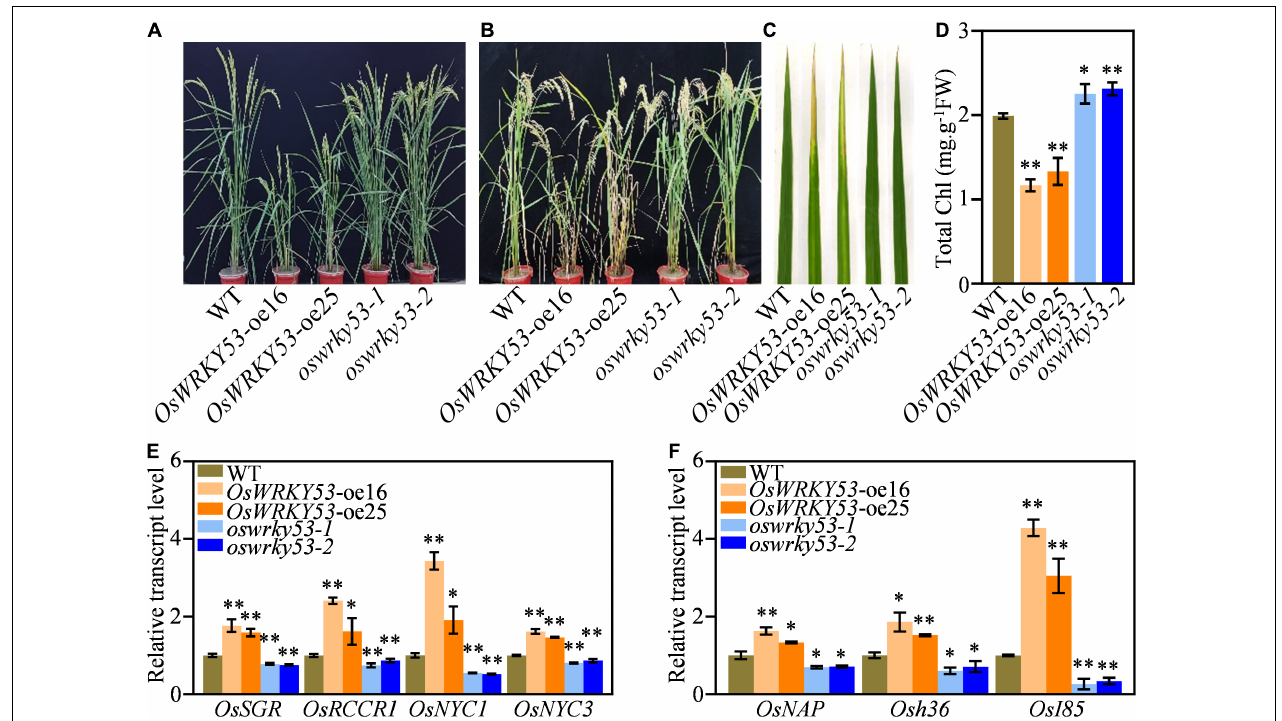
FIGURE 1 | OsWRKY53 promotes natural leaf senescence. (A) Phenotype of OsWRKY53 -oe, oswrky53, and wild type (WT) at the heading stage. (B) Phenotype of OsWRKY53 -oe, oswrky53, and WT at the grain-filling stage. (C) Senescing flag leaf of OsWRKY53 -oe, oswrky53, and WT at the grain-filling stage. (D) Chlorophyll content of senescing flag leaf of OsWRKY53 -oe, oswrky53, and WT at the grain-filling stage. (E) Transcript levels of chlorophyll degradation genes in rice leaves at the grain-filling stage. (F) Transcript levels of senescence-associated genes in rice leaves at the grain-filling stage. Data represent mean ± SD. Asterisks indicate a significant difference determined by two-tailed Student’s t -test at ∗∗ p < 0.01 or ∗ p < 0.05.